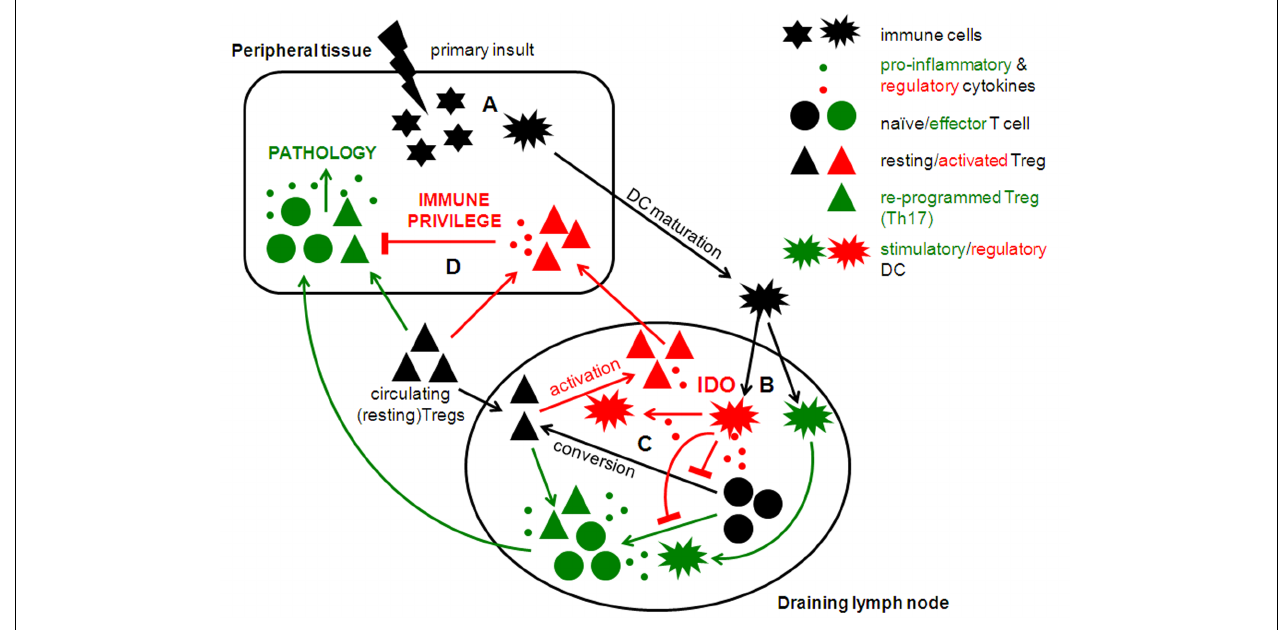
FIGURE 1 | Potential regulatory checkpoints involved in induced immune privilege in local tissue